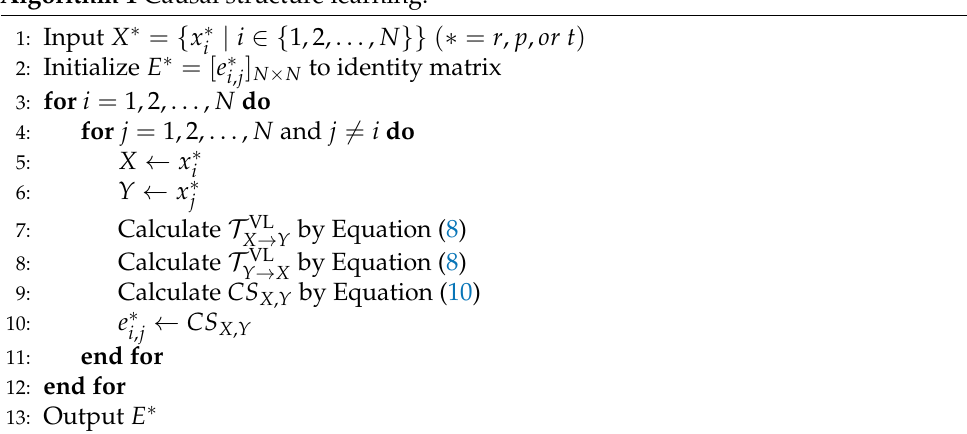
Algorithm 1 Causal structure